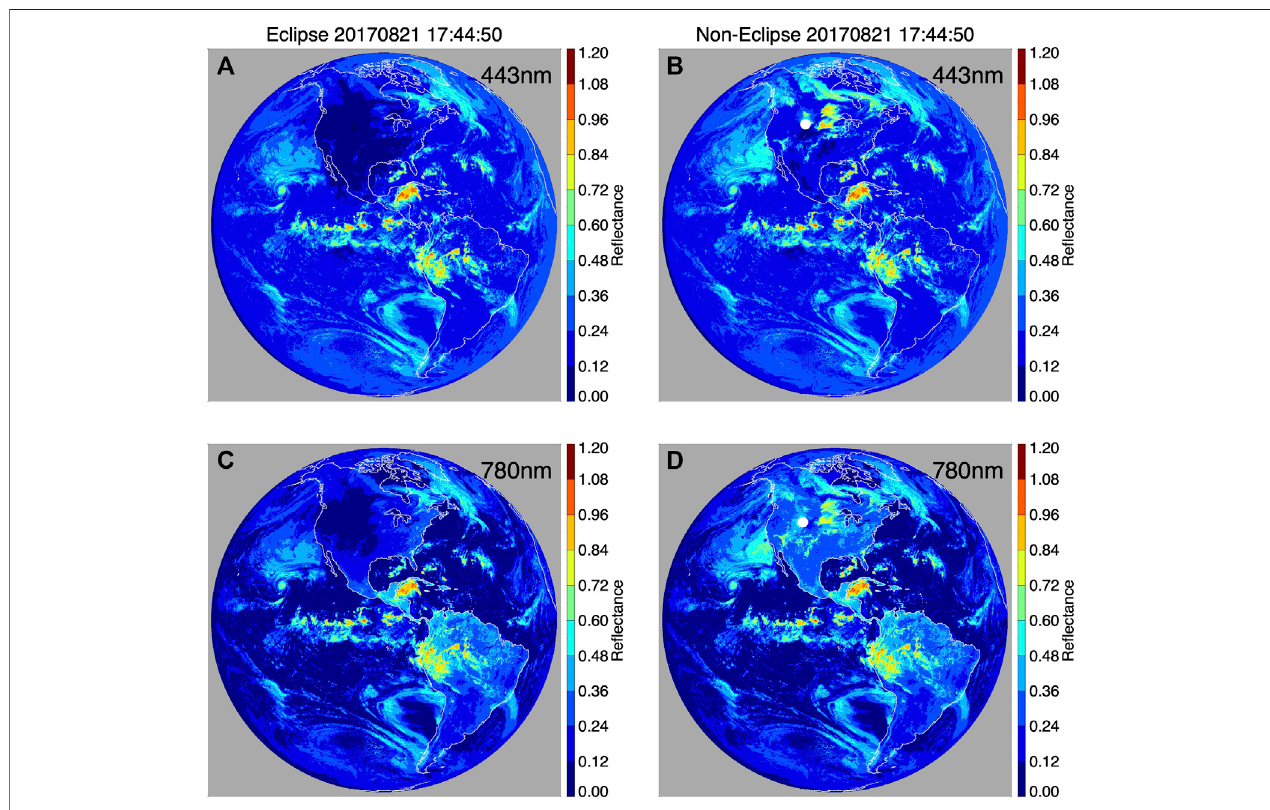
FIGURE 5 | Similar to Figure 4 but for the 21 August 2017 solar eclipse when the center of the Moon ’ s shadow was in Casper, Wyoming.